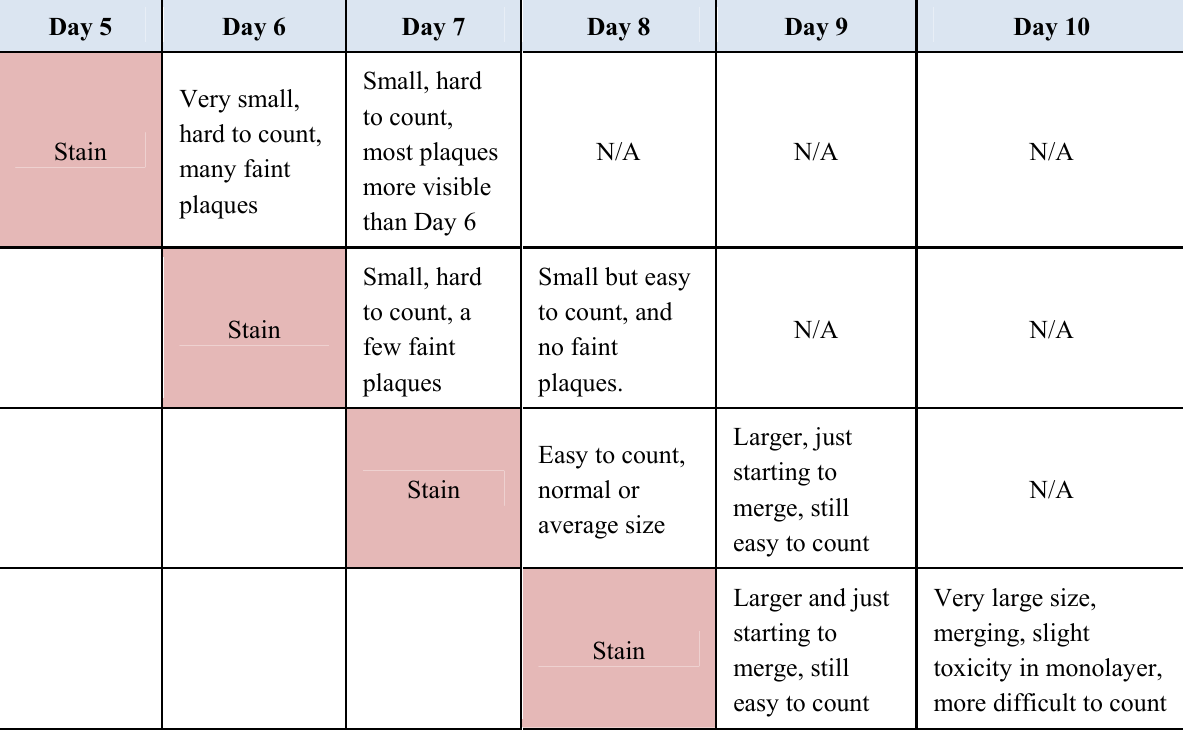
Table 2. EBOV plaque observations based on various staining and counting days. These observations were made in two separate experiments with three replicate wells observed at each dilution in each